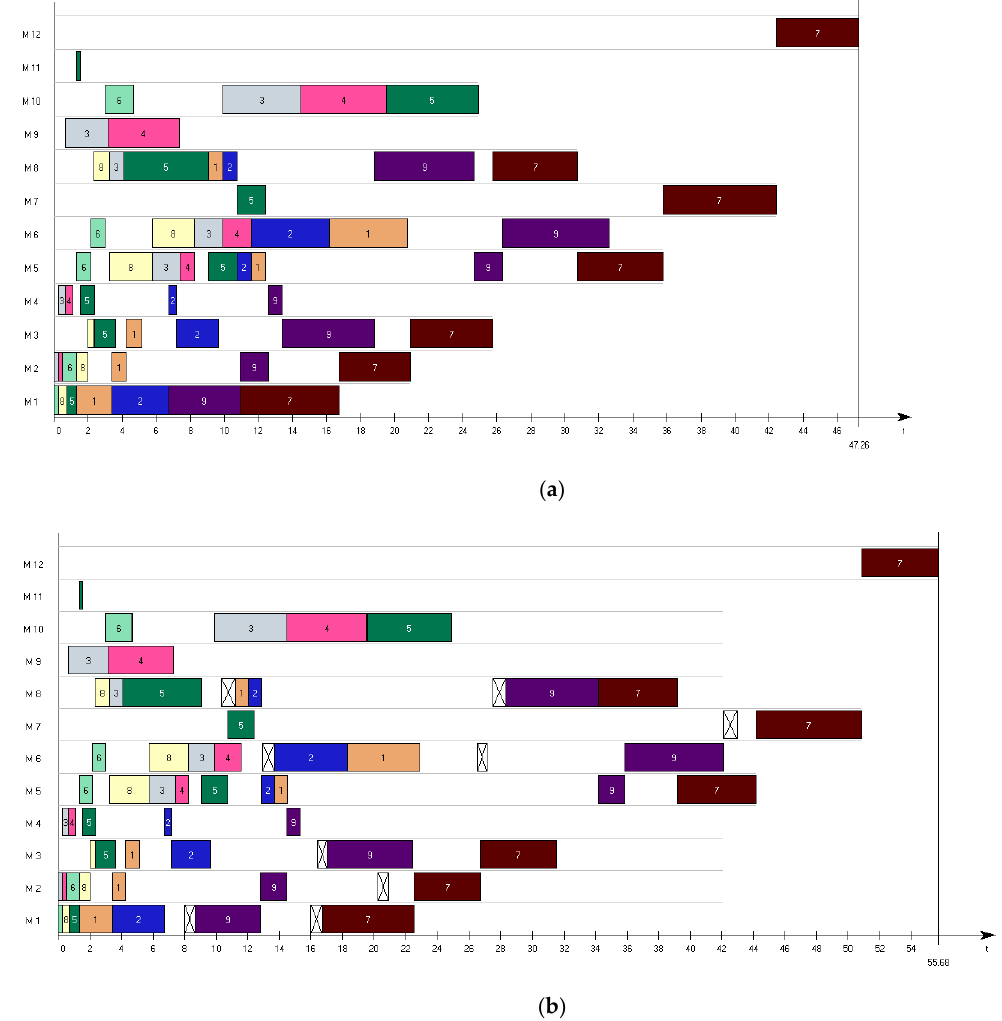
Figure 2. Schedules obtained using the SPT (shortest processing time) rule: ( a ) nominal, ( b ) robust.